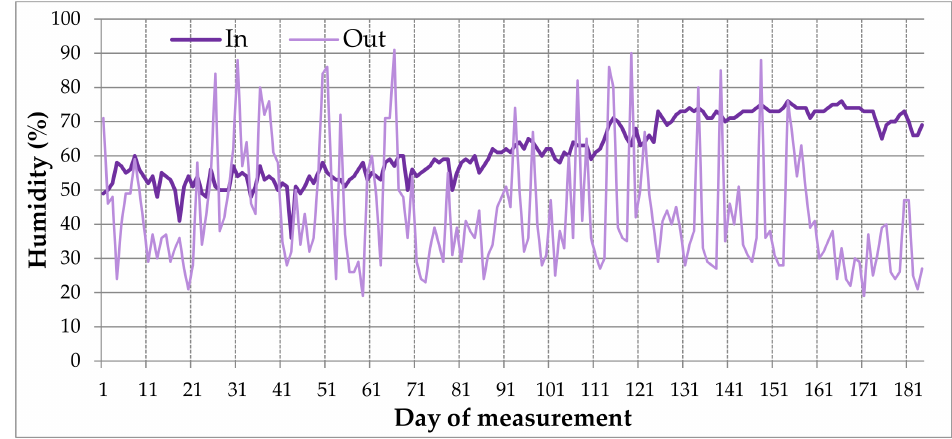
Figure 4. Daily variations of indoor/outdoor relative humidity during the measurement